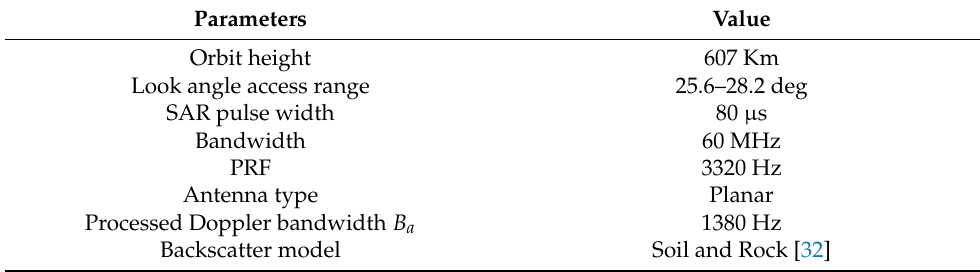
Table 1. Main simulation parameters of the LT-1 in quad-pol